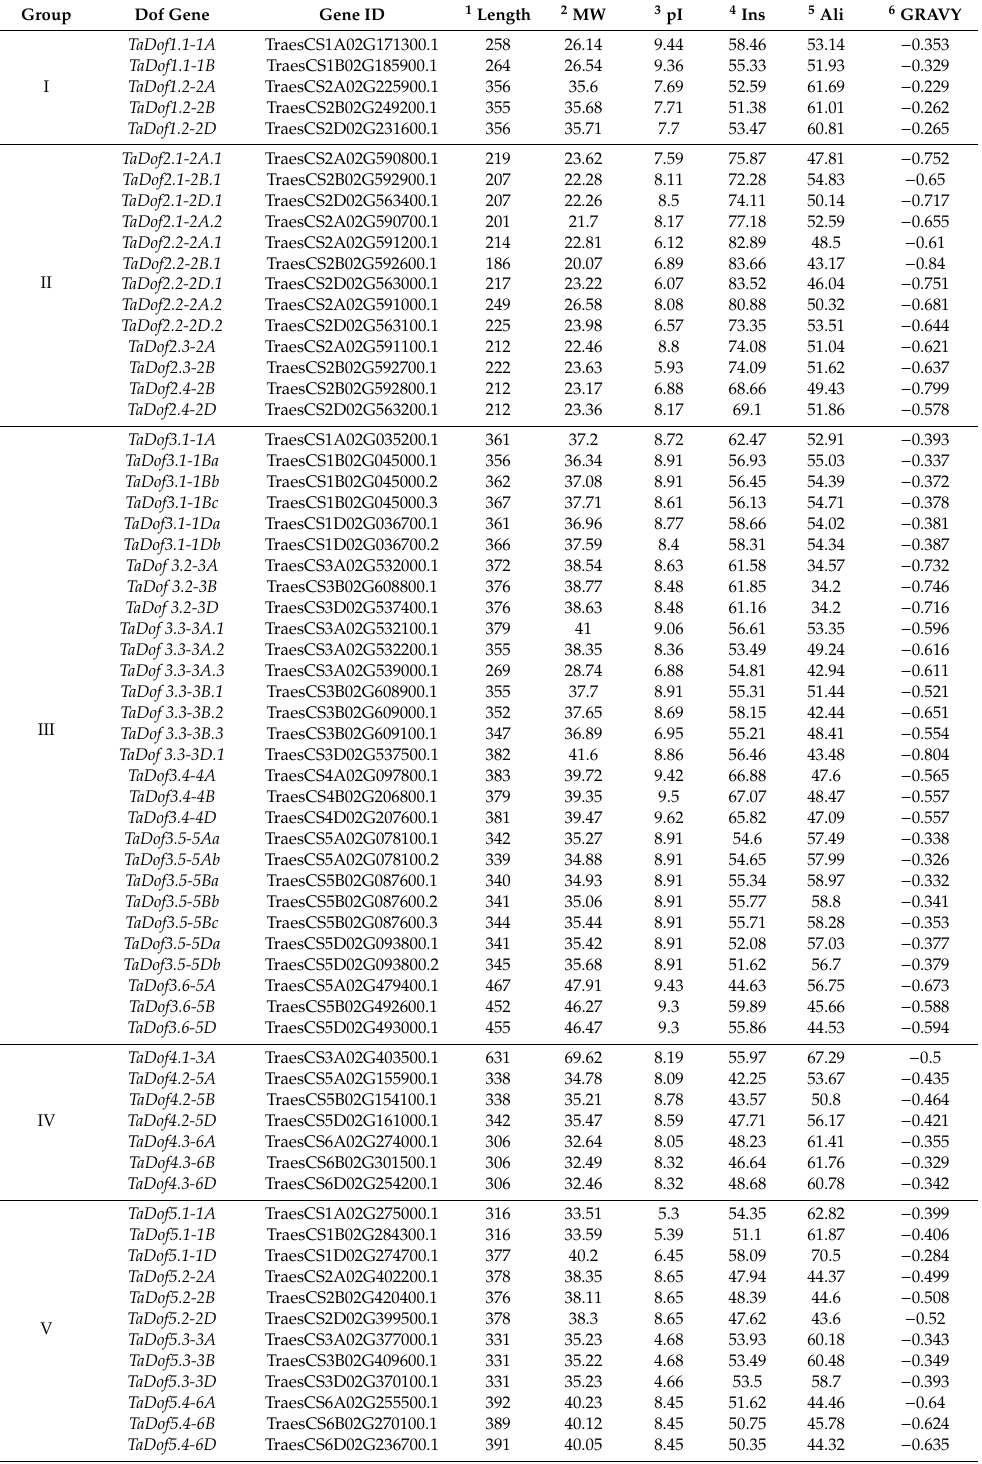
Table 1. DNA binding with one finger (Dof) gene family members in